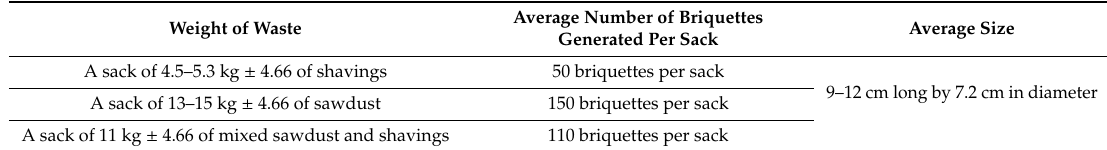
Table 5. Generation of briquettes per sack of waste material.